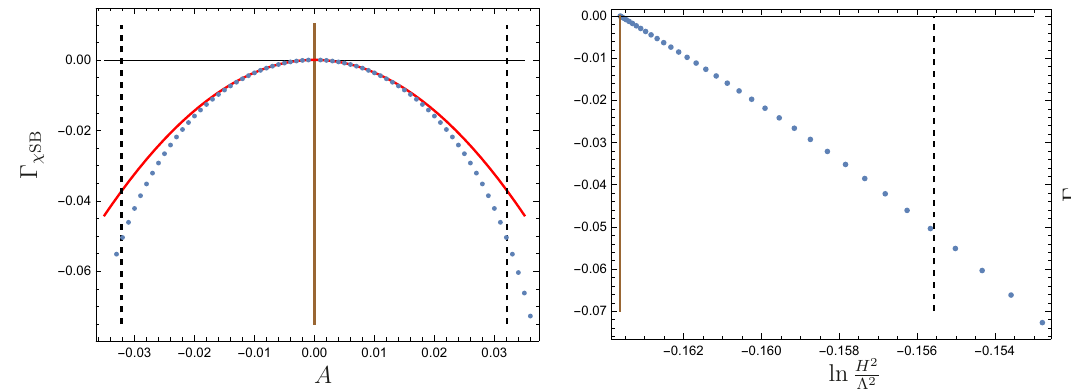
chiral symmetry breaking mode becomes unstable in Figure 12 . The marginal at H = H crit 3 TypeA DFP. In the left panel we parameterize this mode with the order parameter A of the chiral b symmetry breaking of TypeA DFP, see (D.2). In the right panel we show the attenuation Γ of b χ SB this mode as a function of ln H 2 . The solid red curve represent perturbative approximation, close to Λ 2 criticality, see (D.1). The vertical brown lines represent H = H , and the vertical dashed black crit 3 lines represent H = H crit 2